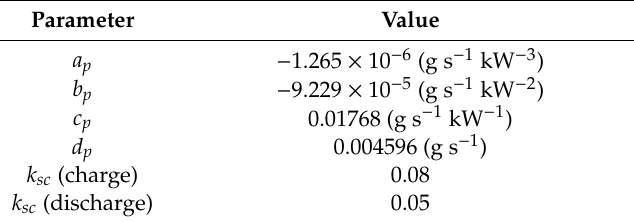
Figure 5. Polynomial curve fitting. Table 6. Control system